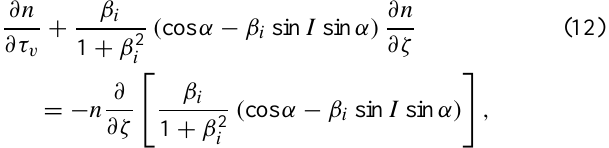
Fig. 5. Typical non-steady-state numerical results of vertical plasma transport inside the north-south PW vortex quadrant (winds point to NE, e.g. see Fig. 2). Ions are driven vertically by the verti- cal Lorentz force and meridional wind forcing of plasma along the magnetic field lines. These results are based on a quasi 2-day PW wind amplitude of 25m/s. The plasma density ( z -axis) is normal- ized to the background mean electron density; the altitude is nor- malized to a scale height H = 10km, whereas 0 in the normalized altitude axis corresponds to the bottom height of 100km. As seen, a broad layer forms in the upper E-region near 130km. See text for more